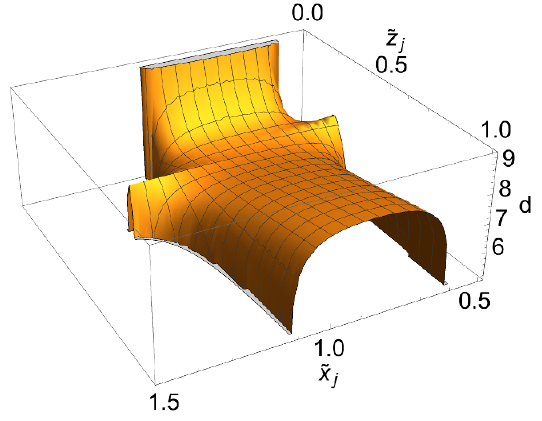
Figure 11 . The distance function d R ( z j ; x j ) for parameters: t b = 0 : 7 ; x min = 0 : 5 ; x max = 1 : 5 ; T L = 2 ; T R = 1 in units where L = 1. The function turns imaginary outside of some region (where the argument of the logarithm in (4.12) turns